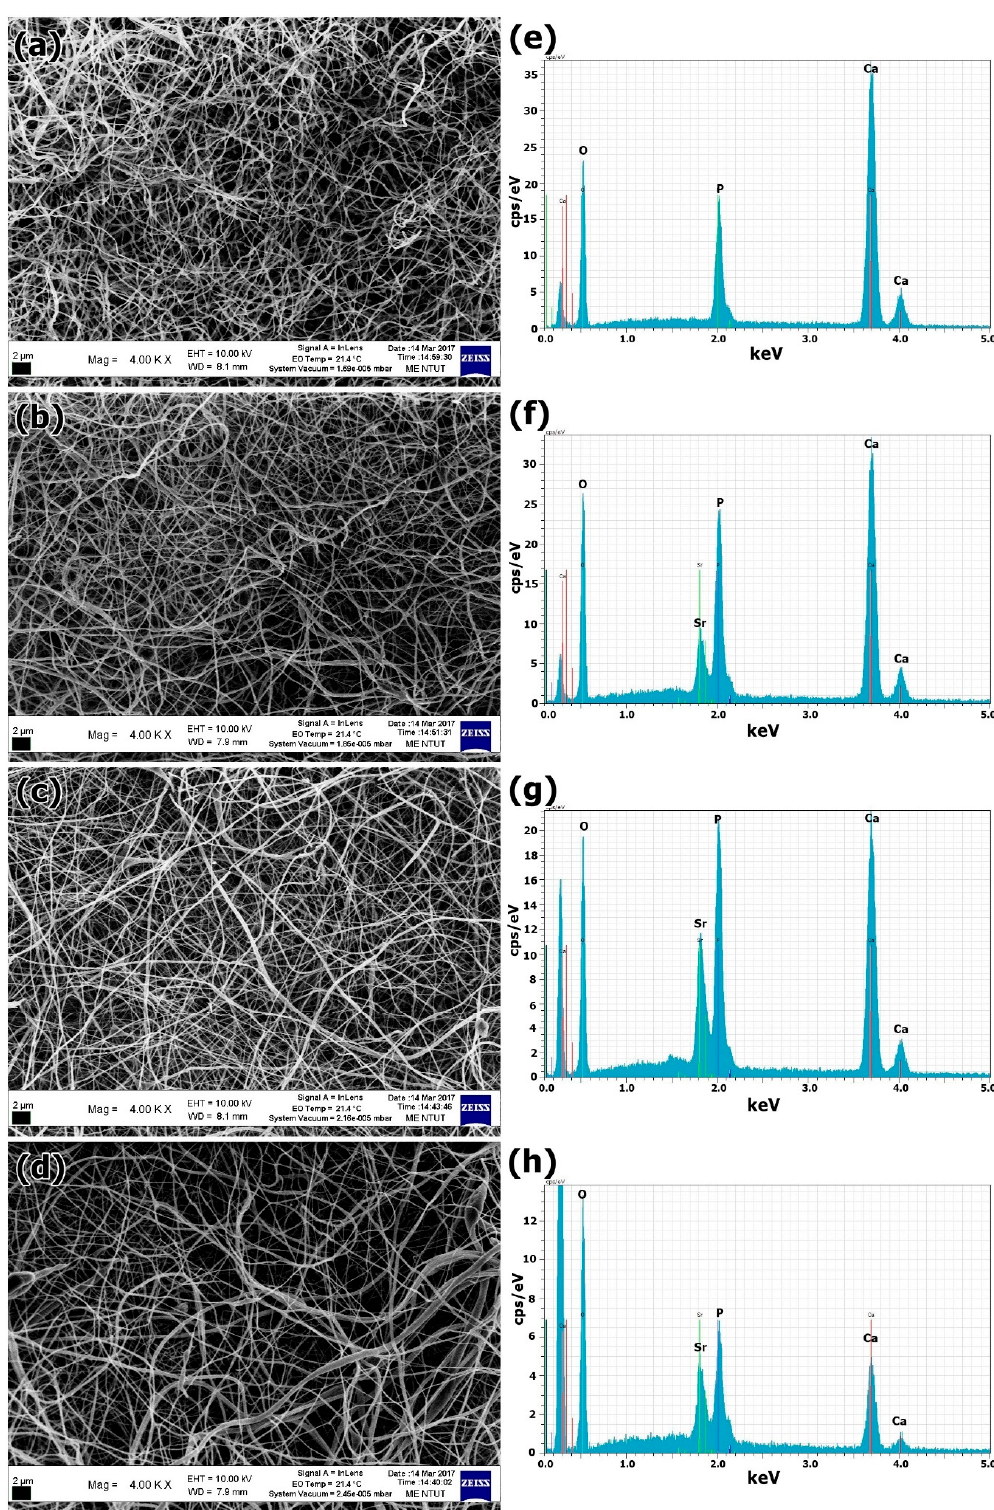
Figure 1. ( a – d ) Scanning electron microscope (SEM) micrographs and ( e – h ) Scanning electron microscopy-energy dispersive X-ray (SEM-EDX) spectra of the mSrHANFs. ( a , e ) 0mSrHANFs; ( b , f ) 1mSrHANFs; ( c , g ) 2mSrHANFs; ( d , h ) 3mSrHANFs.